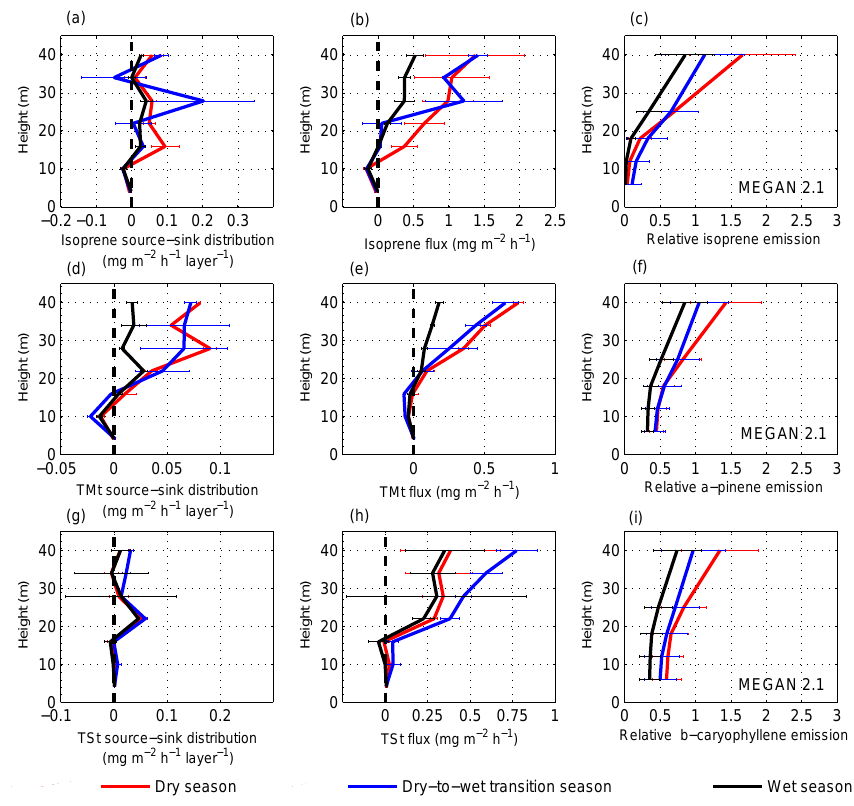
Figure 4. Daytime (10:00–14:00, LT) source-sink distribution inside and above the canopy, cumulative flux estimation, and relative emission modeled by MEGAN 2.1 of isoprene (a, b, c) , total monoterpenes (TMt) (d, e, f) and total sesquiterpenes (TSt) (g, h, i) from the dry season to the wet season. Error bars represent 1 standard